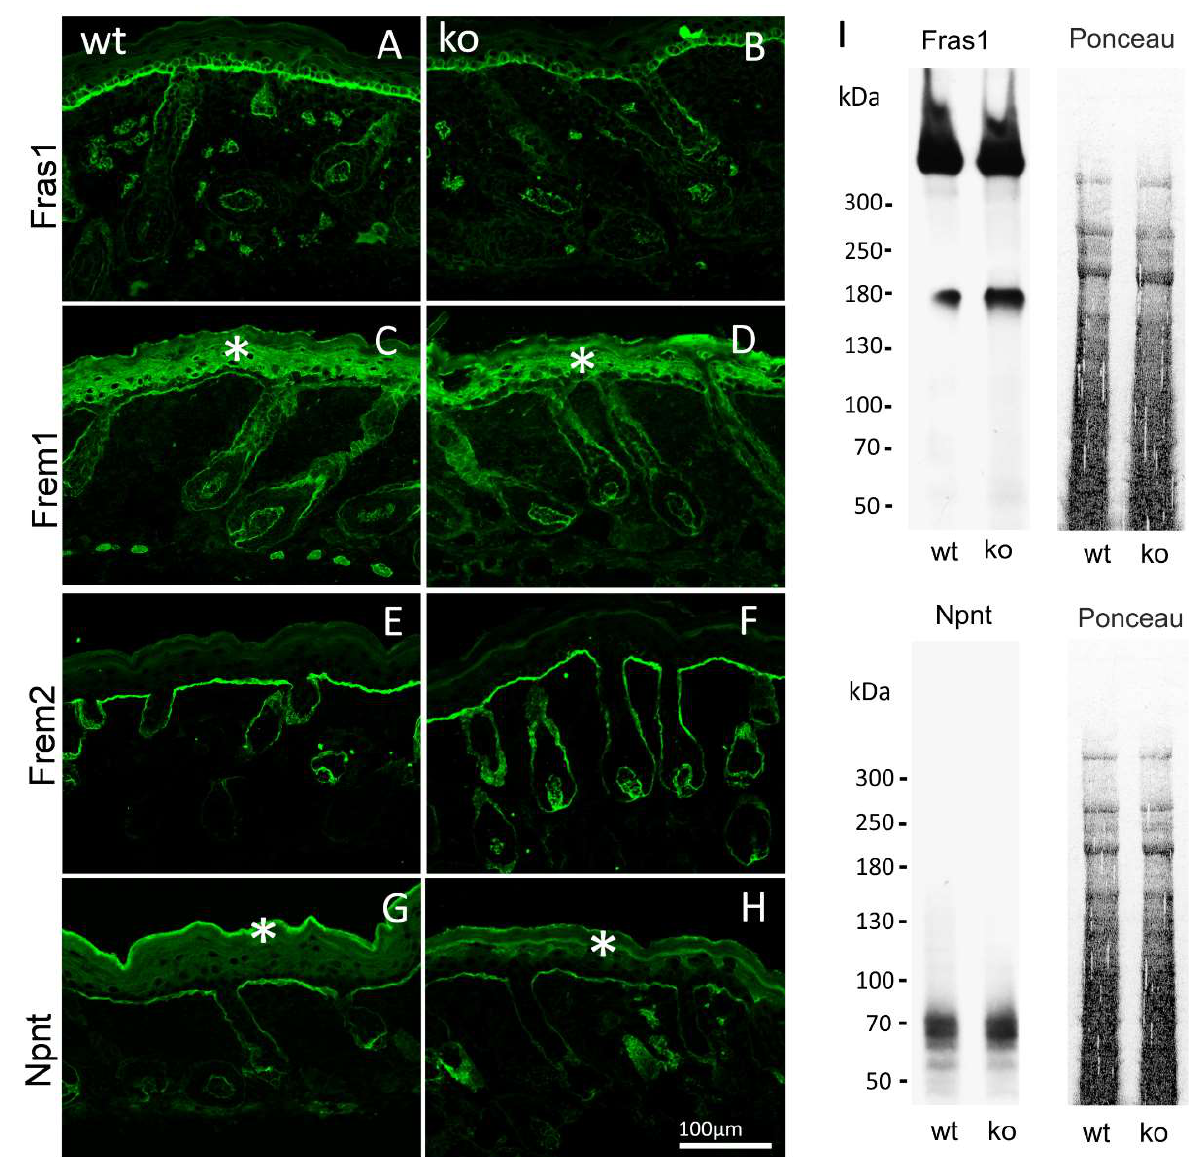
Figure 3 . Immunofluorescence and immunoblot analysis of the Fraser complex proteins in AMACO- deficient newborn mouse. Frozen sections of wildtype ( A , C , E , G ) and AMACO-deficient newborn mouse skin ( B , D , F , H ) were incubated with affinity purified Fras1, Frem1, Frem2, and nephronectin antibodies, followed by AlexaFluor 488-labeled secondary antibodies. Asterisks (*) indicate a region of unspecific staining by the Frem1 and nephronectin antibodies. Scale bar = 100 µ m for ( A – H ). Total head extracts of AMACO-deficient mice analyzed by immunoblot showed comparable signals for Fras1 and nephronectin, in comparison to the wildtype control ( I ). Ponceau staining showed equal